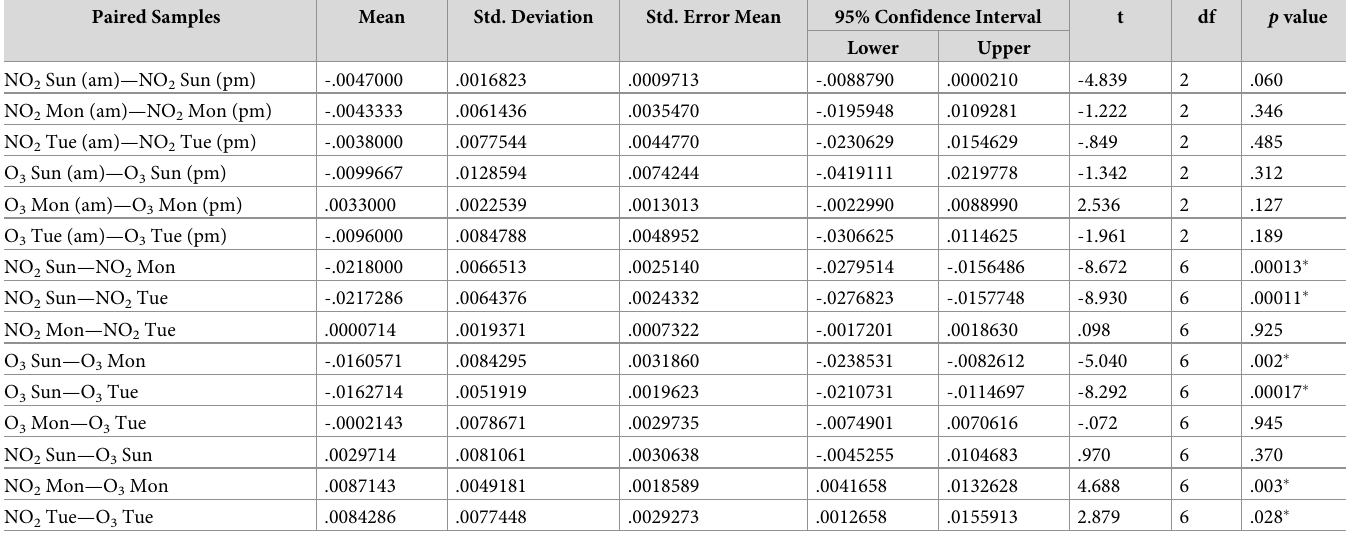
Table 2. Paired sample t-test analysis. Paired Samples